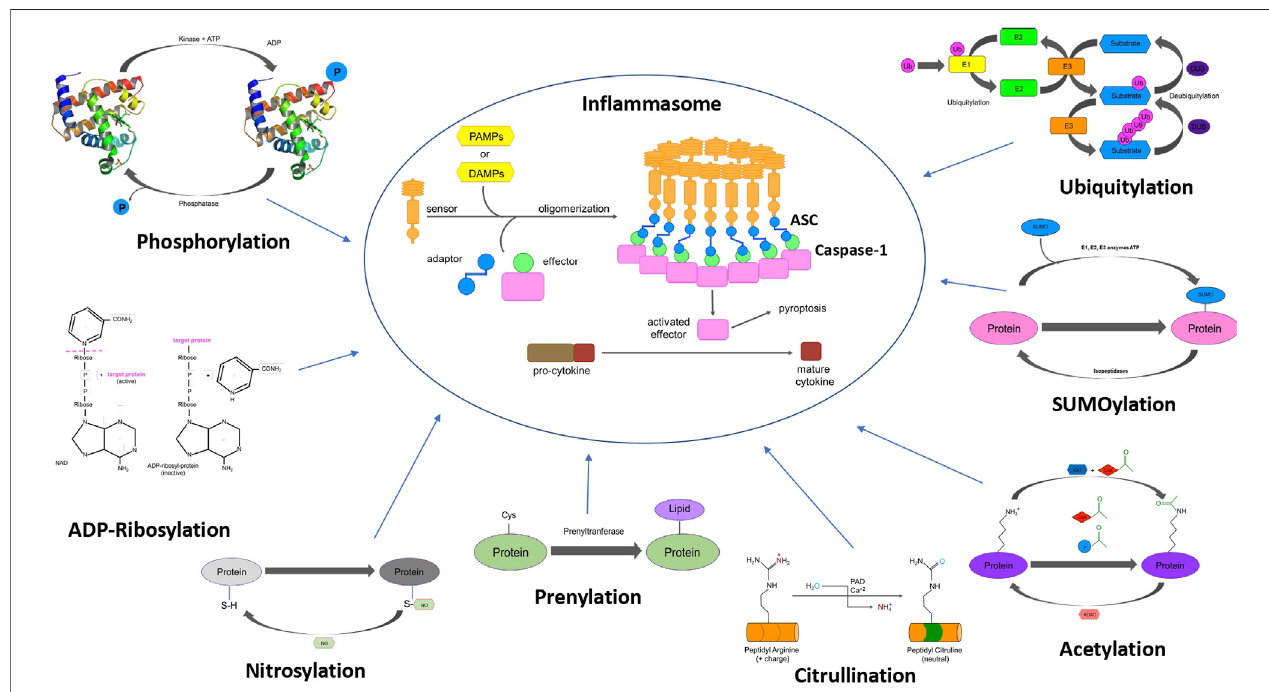
FIGURE 1 | Schematic representation of the PTMs associated with different in fl ammasome components. The fi gure shows assembly of in fl ammasome complex (centre).Differentpost-translationalmodi fi cationsthatmodulatein fl ammasomefunctionsuchasphosphorylation,ubiquitylation,SUMOylation,acetylation,nitrosylation, ADP-ribosylation, citrullination, and